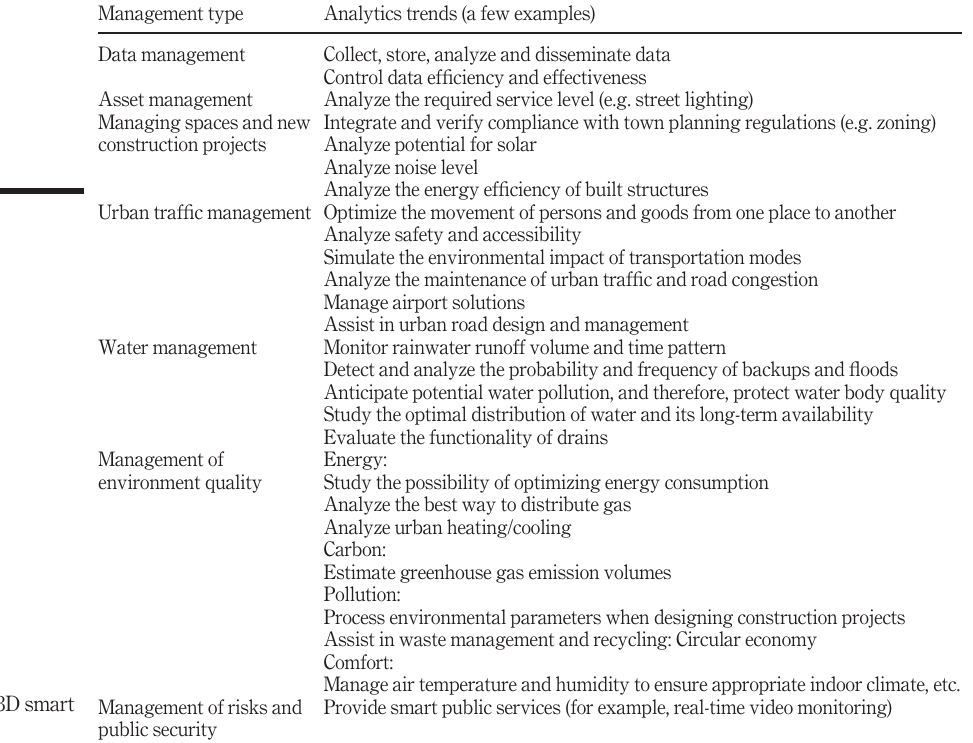
Table II. Towards a 3D